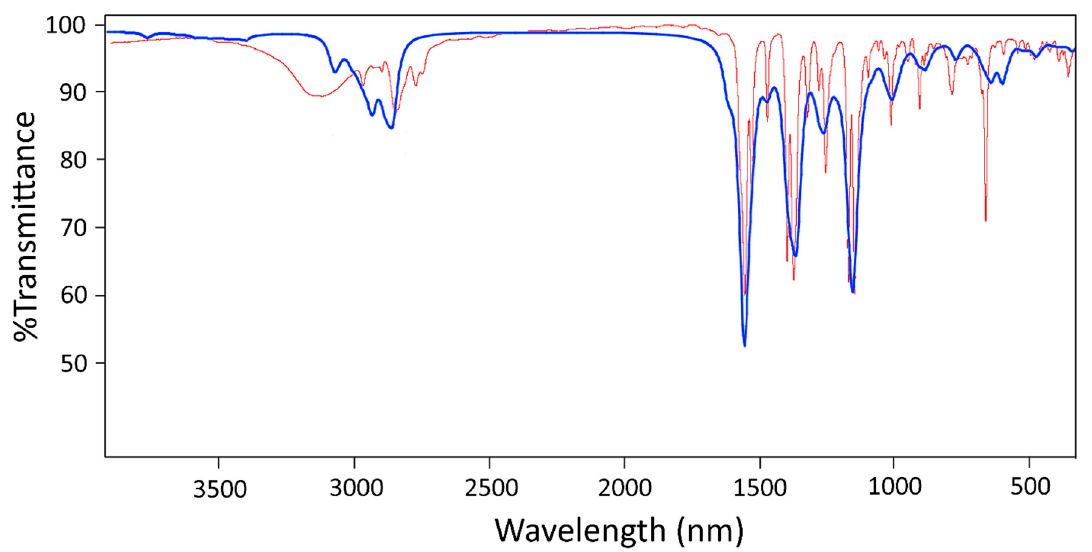
Figure 1. Experimental (red) and DFT simulated (blue) FTIR spectra of [Zn(sal)](H 2 O) complex.